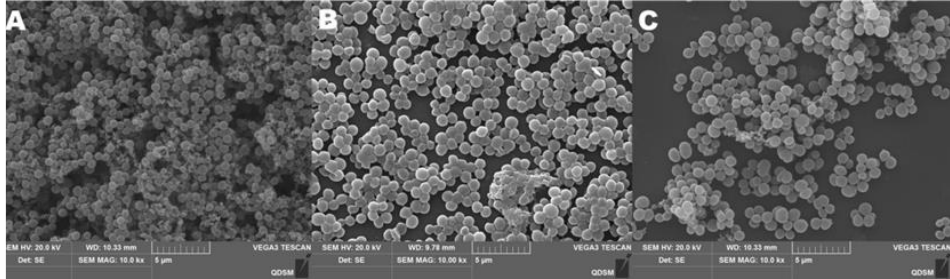
Figure 5. SEM images of S. aureus biofilm formations on medical-grade silicone surfaces with media without treatment ( A ) and with CA ( B ) and CSNP-CA treatments ( C ).